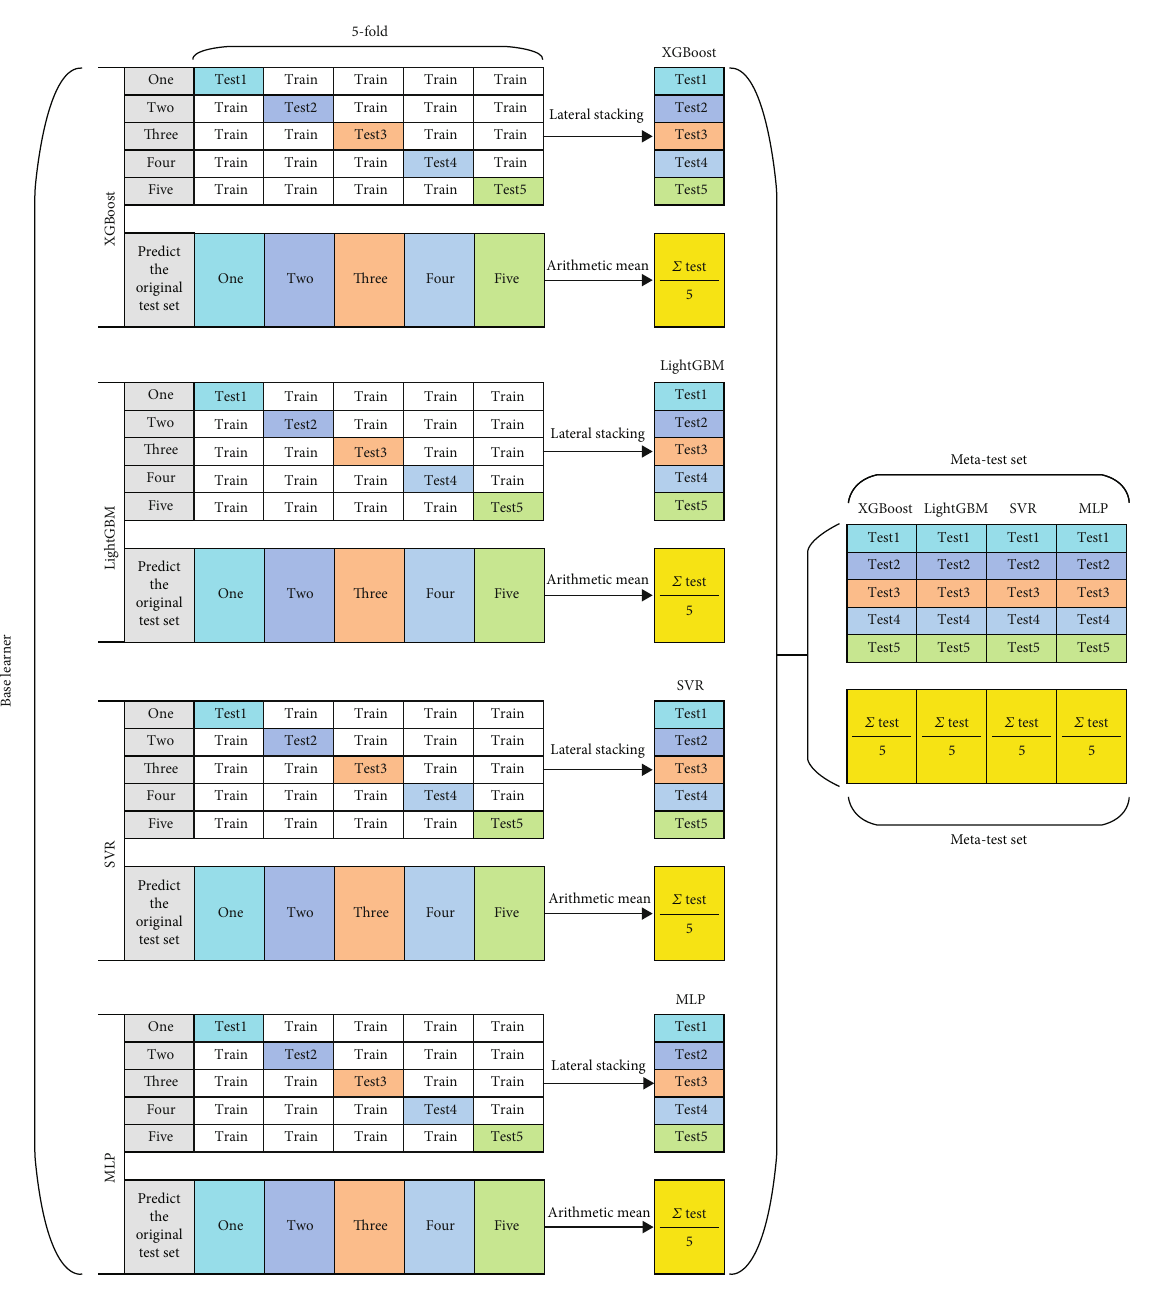
Figure 3: Schematic diagram of base model generation